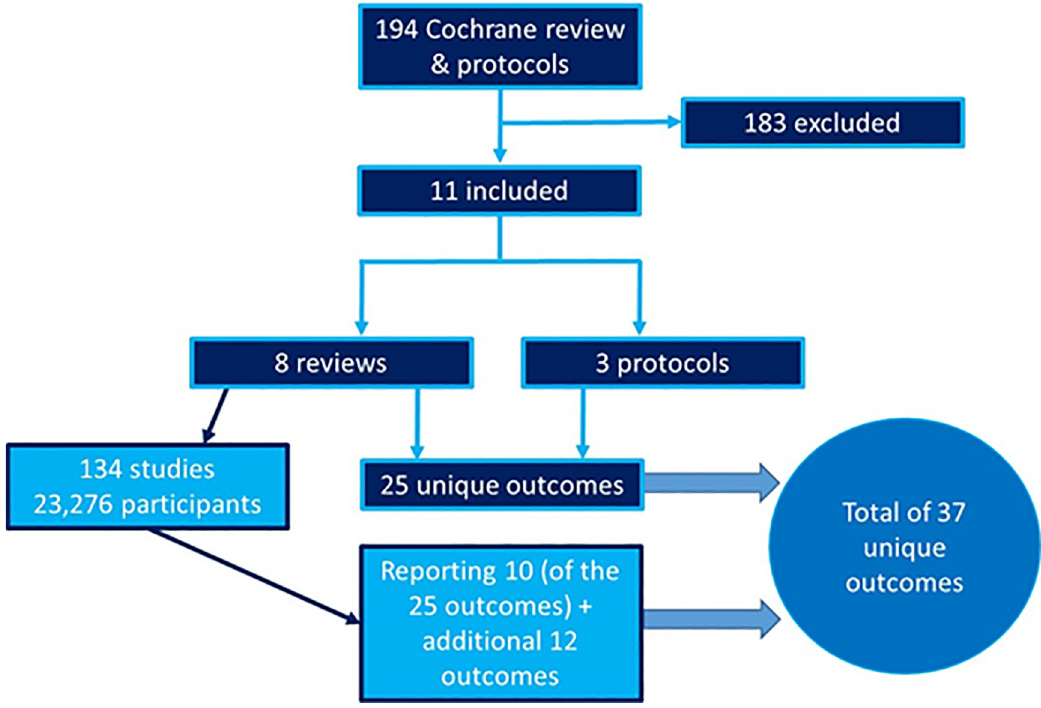
Fig 2. Flow diagram of identification of existing